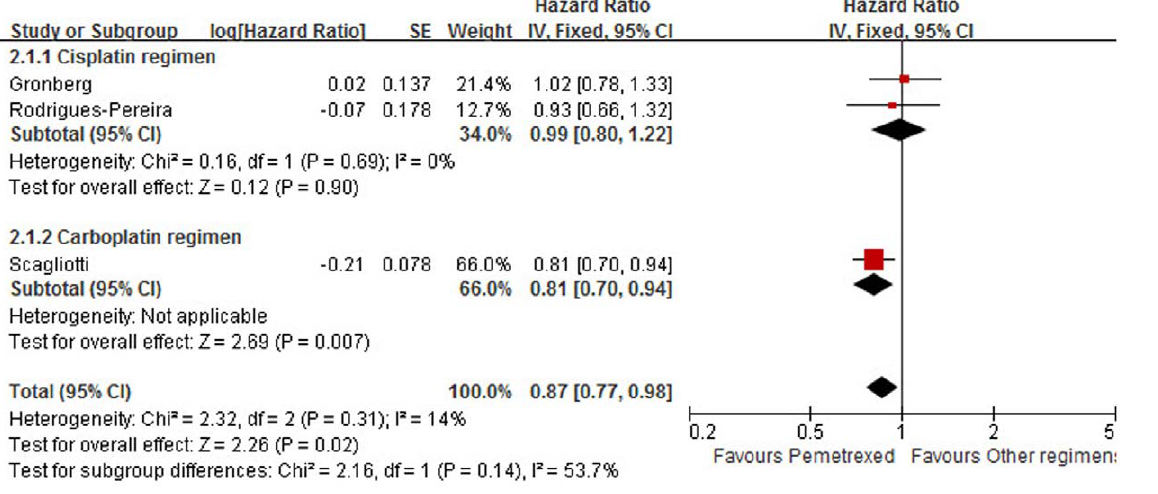
Figure 3. Comparison of overall survival in patients with nonsquamous histology between pemetrexed plus platinum chemotherapy and other platinum-based regimens. Abbreviations: SE, standard error; IV, inverse variance; CI, confidence interval.